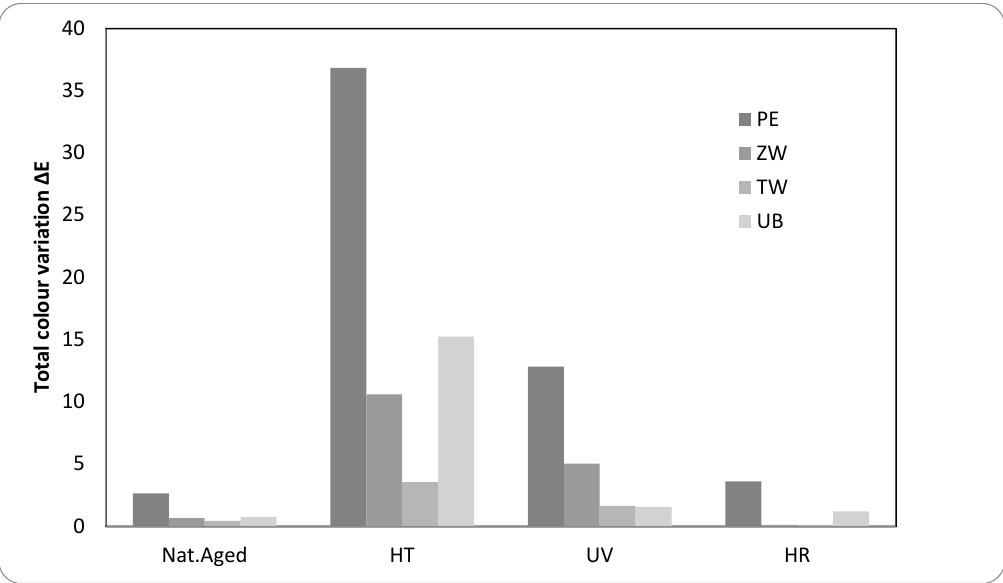
Figure 5. Total colour variations calculated as Δ E for all the mock-ups studied.